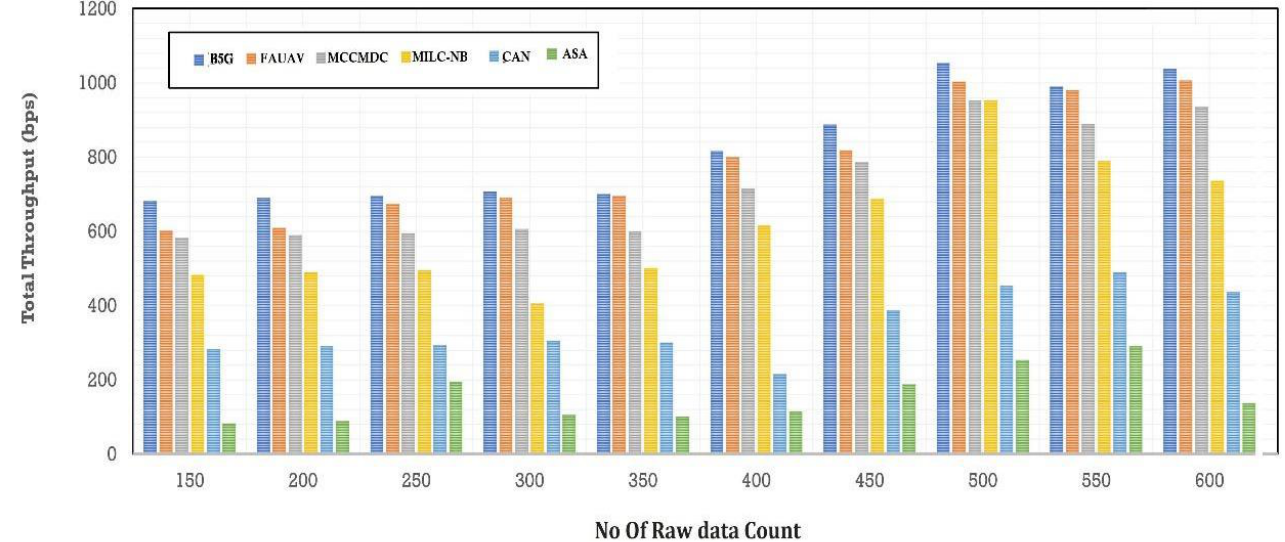
Figure 10. The total throughput after Cryptosystem Assumption.